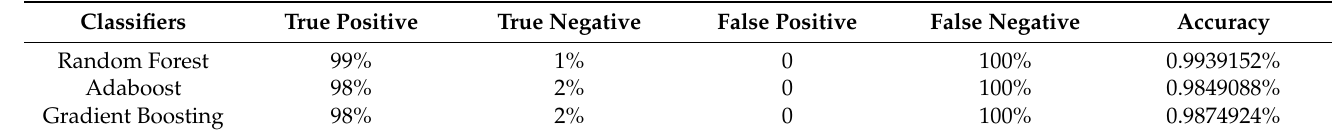
Table 5. Accuracy results for top 3 classifiers: True Positive: normal file detection; False Positive: detection of normal files identified as malicious; False Negative: detection of malicious files identified as